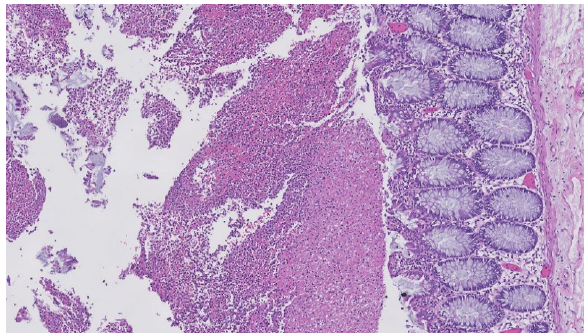
Figure 3: Medium power image of colonic mucosa with fibri- nopurulent exudate and crystals (Hematoxylin and eosin, 5× magnification).